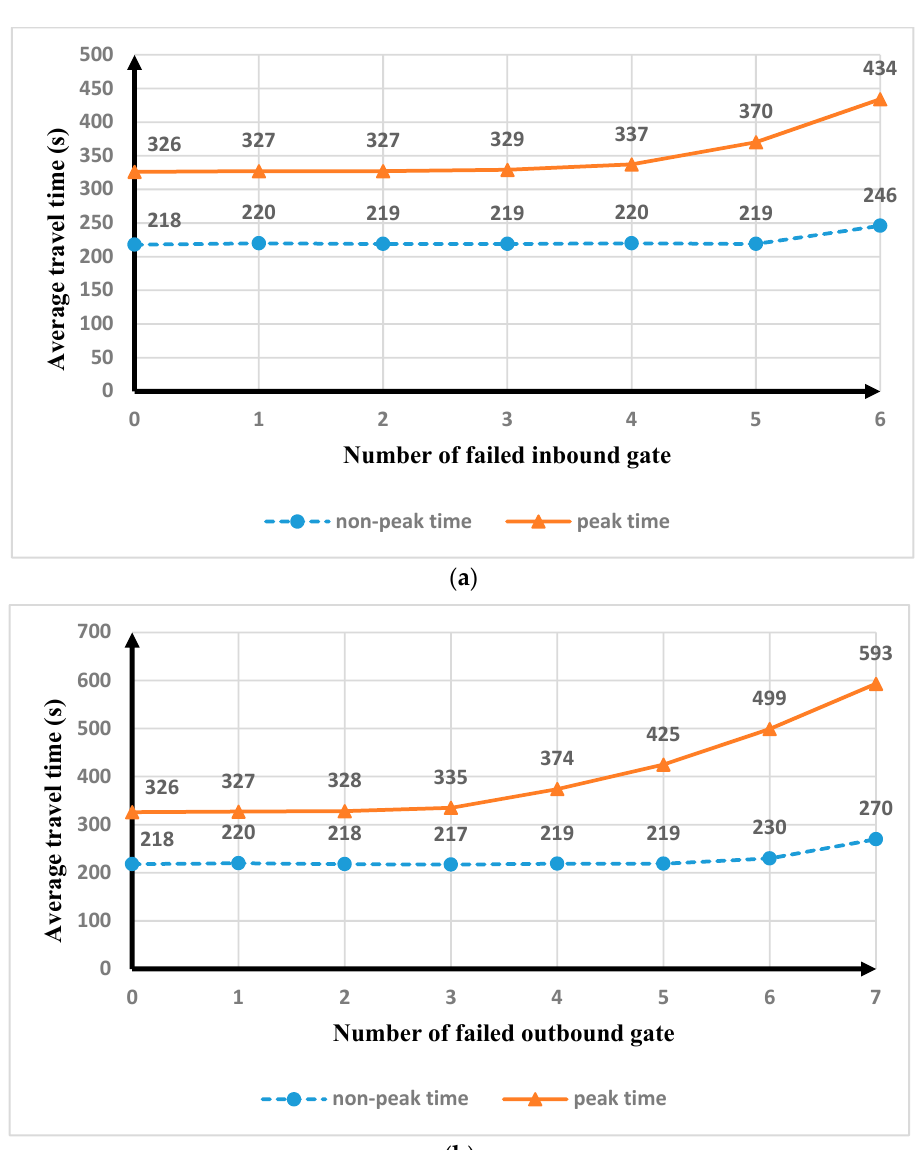
Figure 8. The impact of the number of failed gates on average travel time. ( a ) The impact of the number of failed inbound gates on average travel time; ( b ) The impact of the number of failed outbound gates on average travel time.